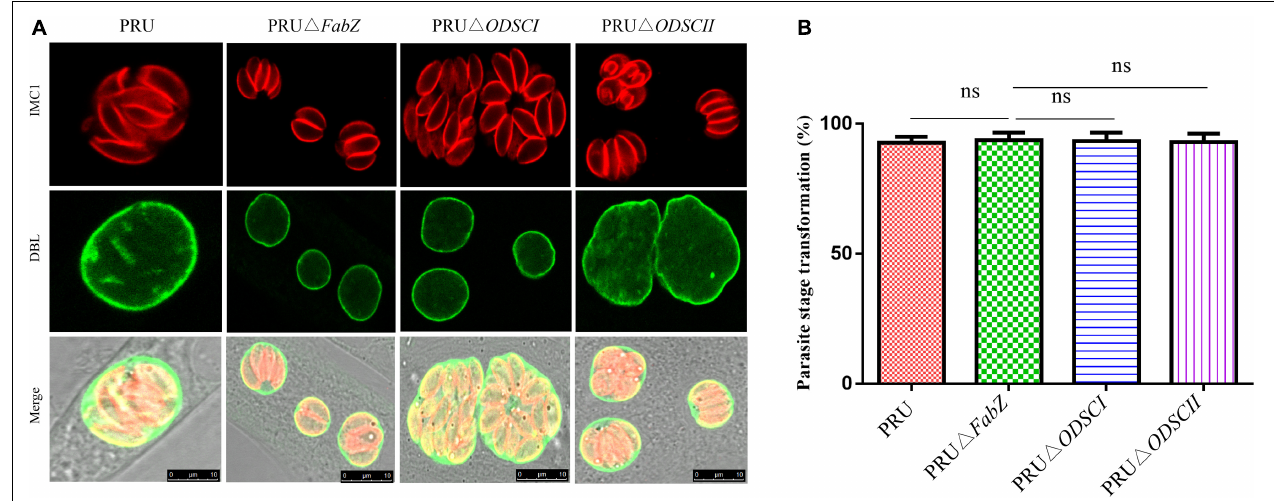
FIGURE 5 | Tachyzoite-bradyzoite transformation of (cid:49) FabZ , (cid:49) ODSCI, or (cid:49) ODSCII using immunofluorescence analysis. HFFs were infected with PRU WT, PRU (cid:49) FabZ , PRU (cid:49) ODSCI, or PRU (cid:49) ODSCII strains and maintained in alkaline medium (pH = 8.2) for 3 days, then the parasites were stained with anti-IMC1 (inner membrane complex) and Alexa Fluor 594 (red). The parasite cyst walls were stained with FITC-conjugated Dolichos biflorus lectin, DBL (green). (A) The deletion of FabZ , ODSCI , or ODSCII in PRU strain did not have any remarkable impact on the tachyzoite-bradyzoite transformation ability. Scale bars, 10 µ m. (B) No significant difference in the parasite stage transformation was detected between any of the tested parasite strains.